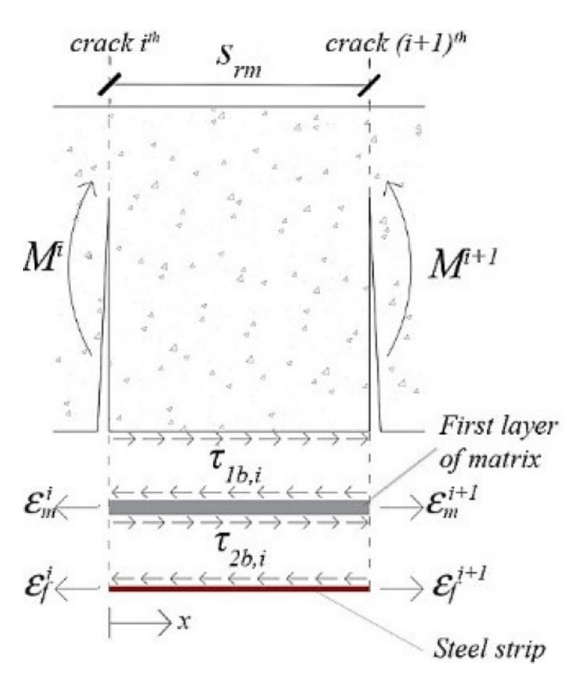
Figure 5. Concrete tooth between two flexural